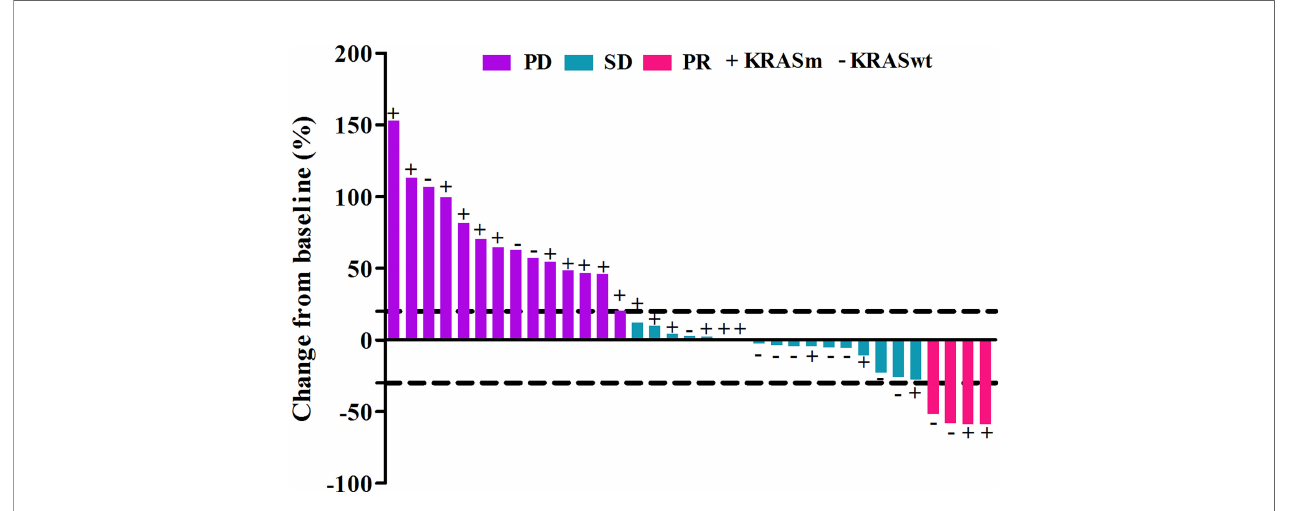
FIGURE 1 | Tumor response in patients treated with fruquintinib plus pd-1 inhibitor with different kras status.